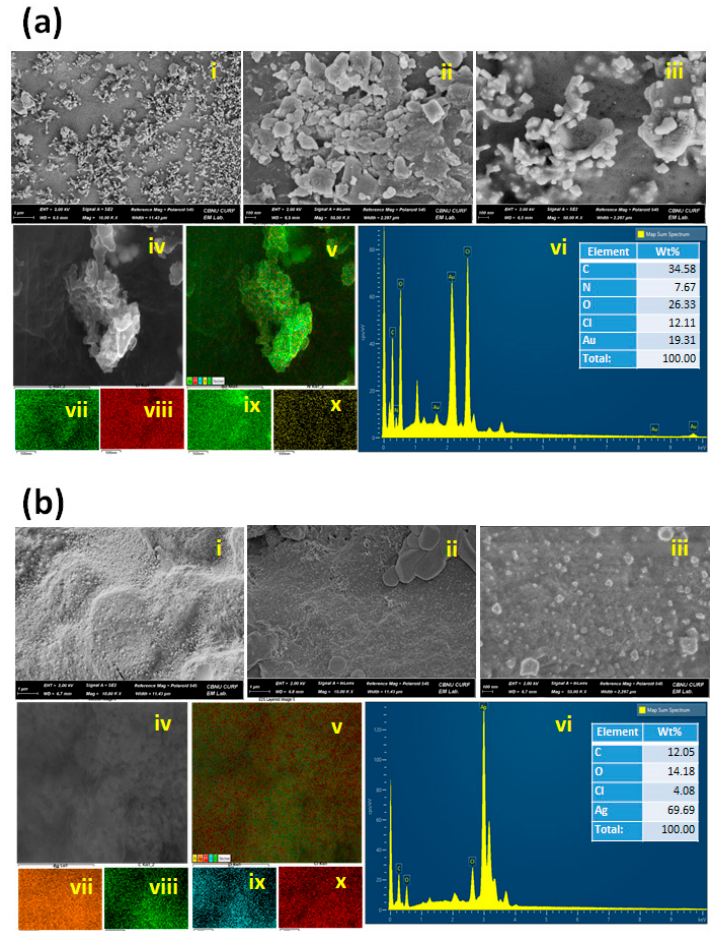
Figure 2. Field-emission scanning electron micrograph of SP-synthesized AuNPs and AgNPs. ( a ) ( i – iii ) Size and morphology of the synthesized AuNPs; scale bar = 100 nm. ( iv – ix ) Elemental mapping for purity and distribution analysis in the selected electron micrograph region of the nano-gold sample. ( x ) Energy-dispersive X-ray spectrum of synthesized AuNPs (inset table presents element ratios in wt%). ( b ) ( i – iii ) Size and morphology of the synthesized AgNPs; scale bar = 100 nm. (iv-ix) Elemental mapping for purity and distribution analysis in the selected electron micrograph region of the nano-silver sample. (x) Energy-dispersive X-ray spectrum of synthesized AgNPs (inset table presents element ratios in wt%).